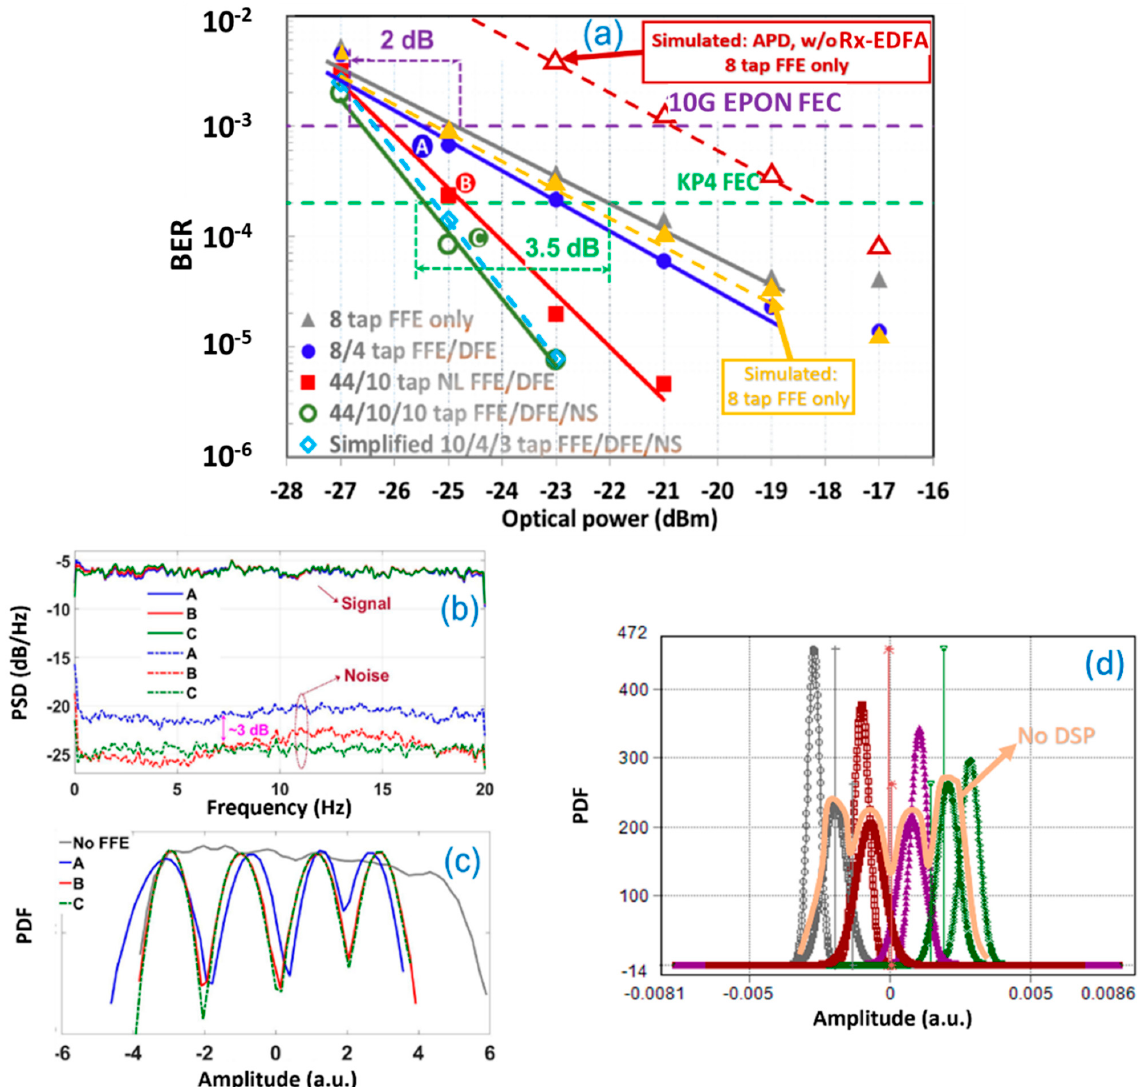
Figure 4. ( a ) BER vs. optical power performance using different equalization approaches for transmission of 20 km single-mode fiber (SMF) and ( b ) power spectral densities. ( c ) Histograms of signals corresponding to DSP configurations marked in BER curves with − 25 dBm optical power. ( d ) Received simulated histograms for avalanche photodiode (APD) case (w/o receiver EDFA) with and without DSP at − 25 dBm optical power.